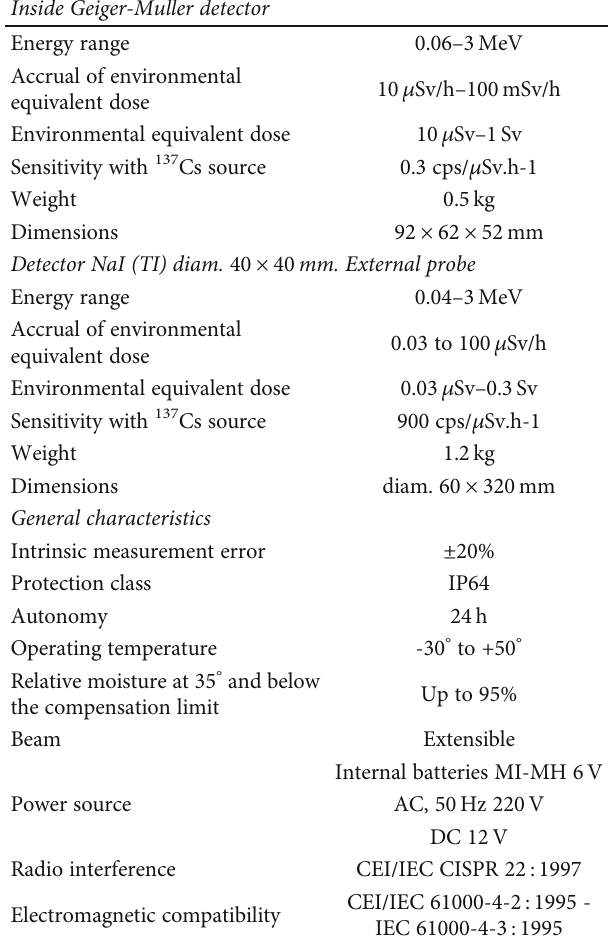
Table 1: Technical speci fi cations of the radiation